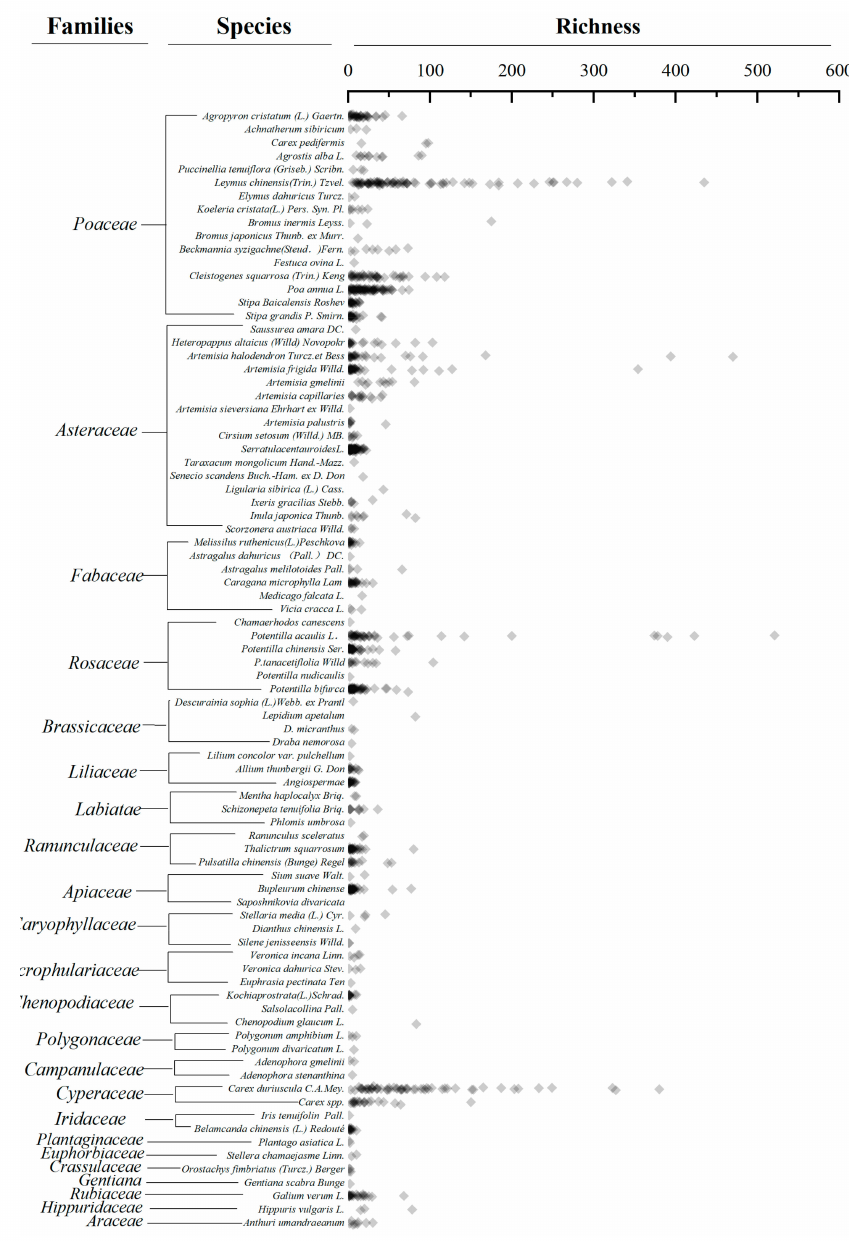
Figure A1. A summary of the total plant families and species of the sampled